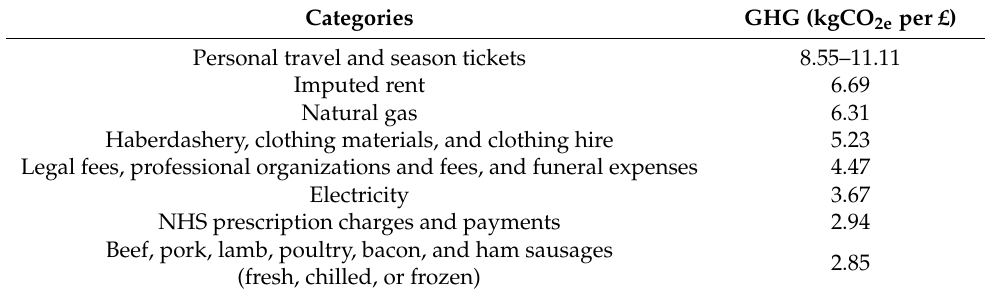
Table 4. Highest GHG emissions as a function of consumption in the UK from 2007 to 2017 [42].